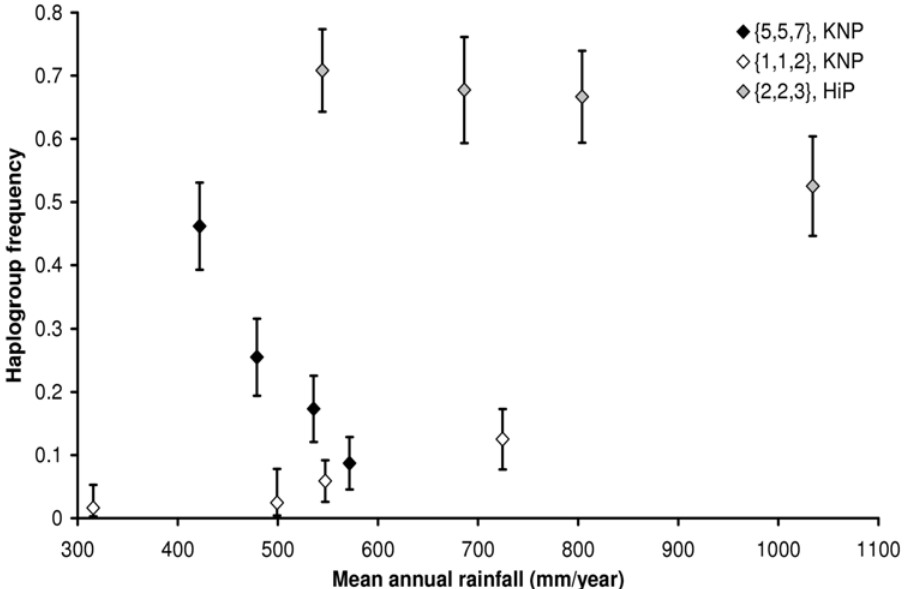
Figure 2. Correlation between haplogroup frequency and mean annual rainfall. { n 1 , n 2 , n 3 }: haplogroup. Black diamonds: mean annual rainfall in the three years before birth. Open diamonds: rainfall in the second year before birth. Grey diamonds: rainfall in the year of birth. Error bars: standard error ( ffiffiffiffiffiffiffiffiffiffiffiffiffiffiffiffiffiffiffiffiffiffi p (1 { p ) = N p ), except for the two lowest data points of haplogroup {1,1,2} in which the haplogroup was observed only once. Here they correspond to a chance $ 84% of sampling # 1 (positive error bar) or $ 1 haplogroup (negative error bar). Sample sizes were equalized as much as possible.